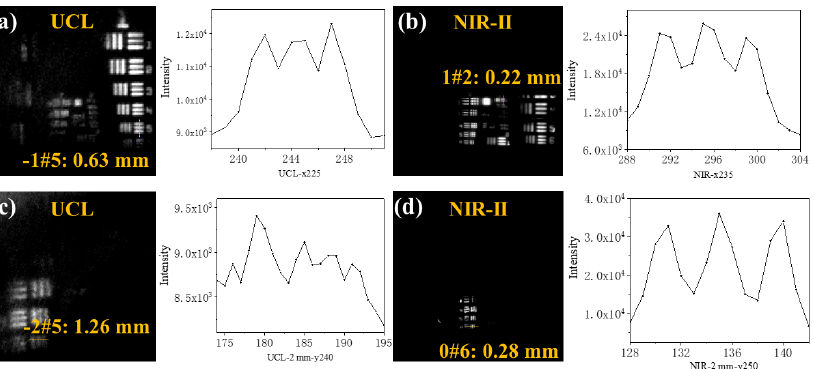
Figure 5. The fluorescence images of nanoparticles were covered with different pork tissues in different fluorescent windows. UCL band (660 ± 10 nm): ( a , c ); NIR-II window (1535 ± 45 nm): ( b , d ). ( a , b ) are covered with no tissue. ( c , d ) are covered with 2 mm tissue. Different groups of line pairs correspond to minimum resolutions according to the comparison with the R3L3S1N card. A plot with pixel intensity is shown in the images, along with the corresponding yellow line.